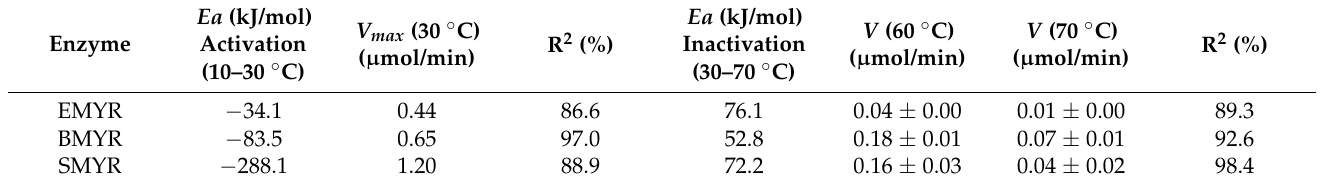
Table 4. Estimation of activation and inactivation Ea using Arrhenius equation (Equation